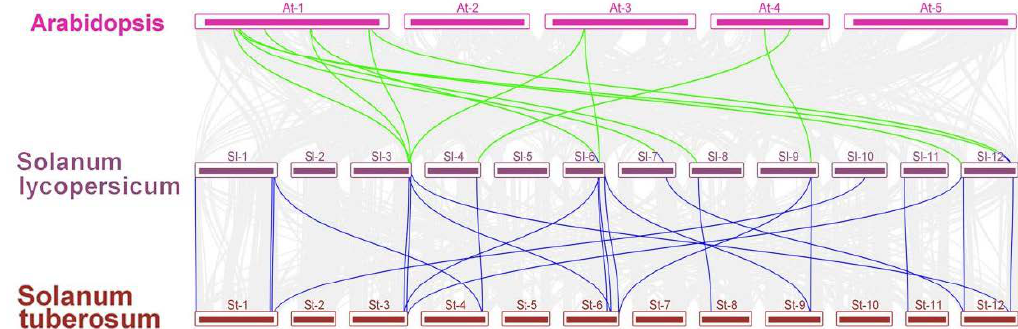
Figure 6. Syntenic relationships between homologous SlJAZ genes of tomato and other species. The JAZ gene pairs between different species are highlighted with different colored lines.